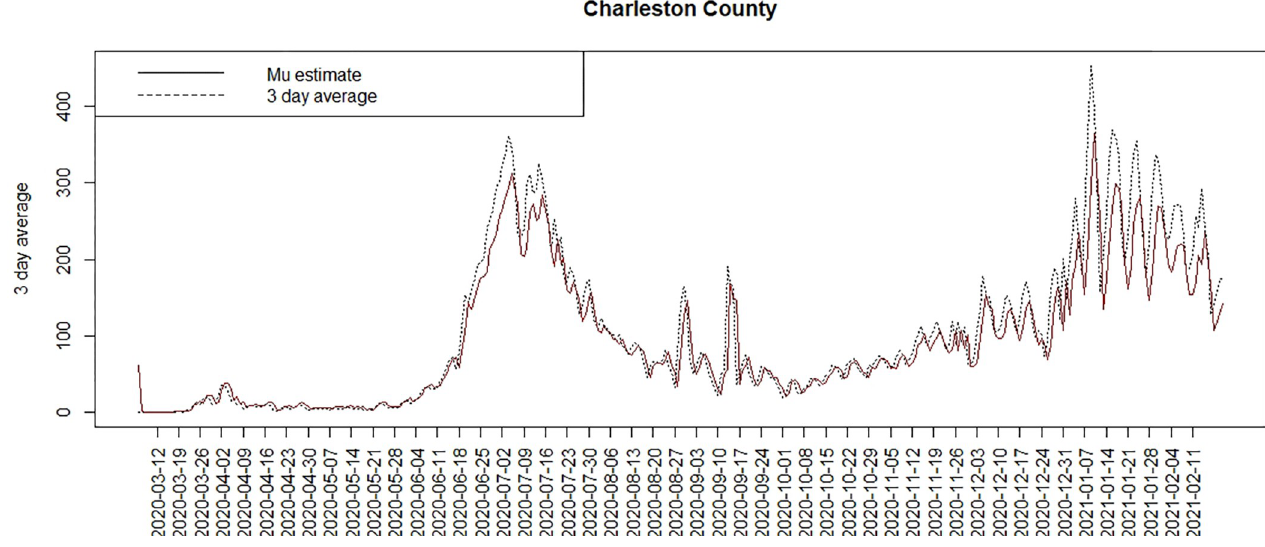
Fig 8. Count and posterior mean risk for Charleston county under model